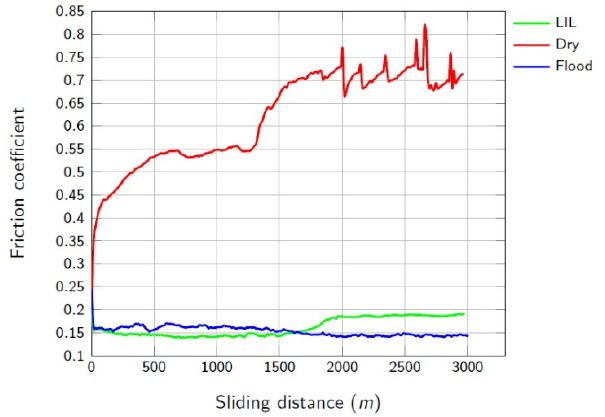
Figure 5. Friction coefficient evolution for 3000-m sliding distance pin-on-disk test.